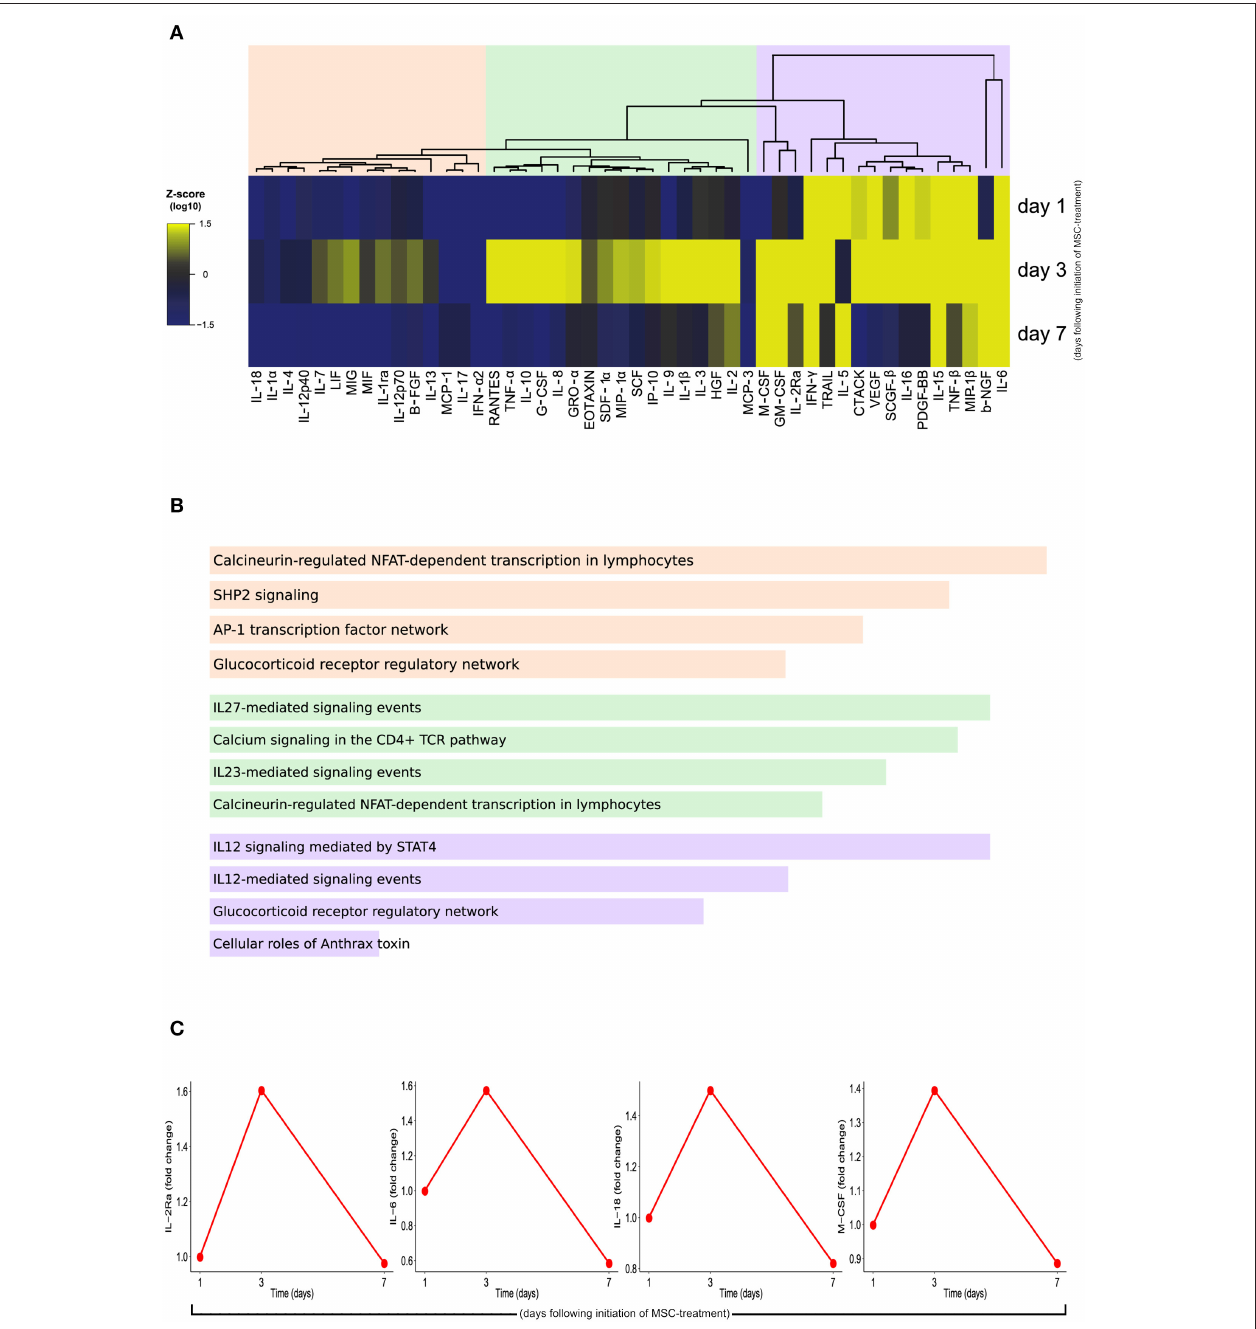
FIGURE 2 | Expression profile of cytokines, chemokines, and growth factors by Luminex assay. (A) A heatmap was designed to depict the overall profile of biomarkers among times, according to log 10 of Mean Fluorescent Intensity (MFI). A one-way hierarchical cluster analysis (Ward’s method) was performed. The dendrograms represent Euclidean distance. (B) Enrichment analysis for each cluster at NCI Nature database. The top four pathways are shown, ranked by the p -value. (C) Interlukin (IL)-2Ra, IL-6, IL-18, and macrophage colony-stimulating factor (M-CSF) showed a higher fold-change ( ± 0.5) of MFI over time. The samples were collected on the day of the first MSC infusion (D1, pre-infusion), the second MSC infusion (D3, pre-infusion), and the 7th day following cell therapy (D7).